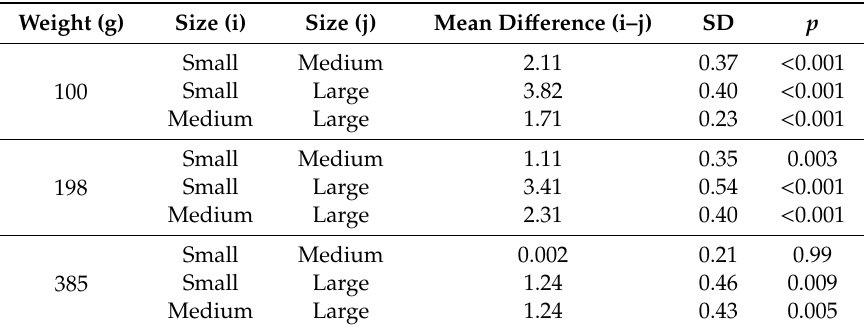
Figure 3. Interaction e ff ects of size and weight of cookie box on satisfaction. Table 8. Satisfaction comparison of the three cookie box sizes.